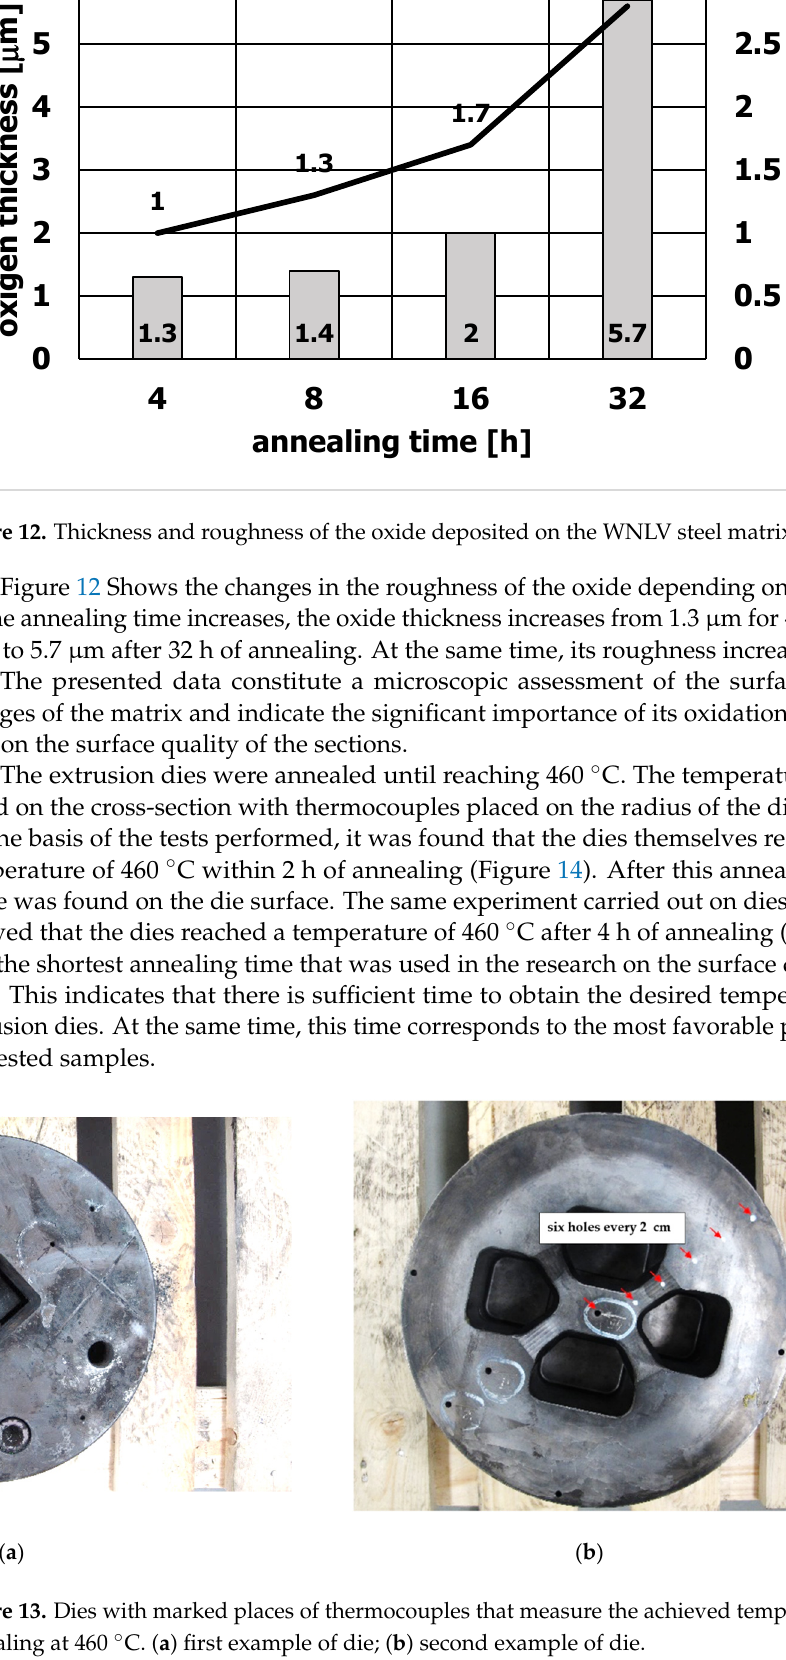
Figure 11. Roughness of extruded aluminum profiles and the oxide deposited on the die.